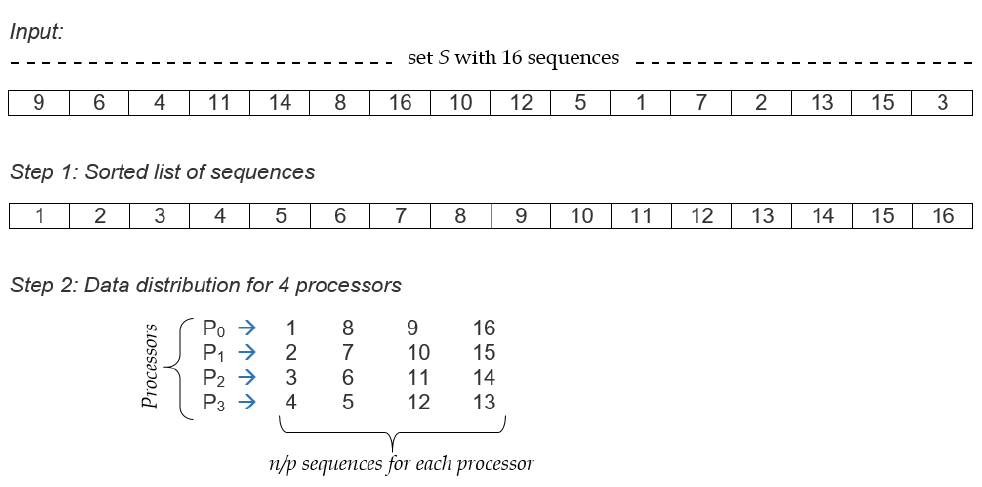
Figure 13. An example of data distribution strategy for 4 processors and 16 input